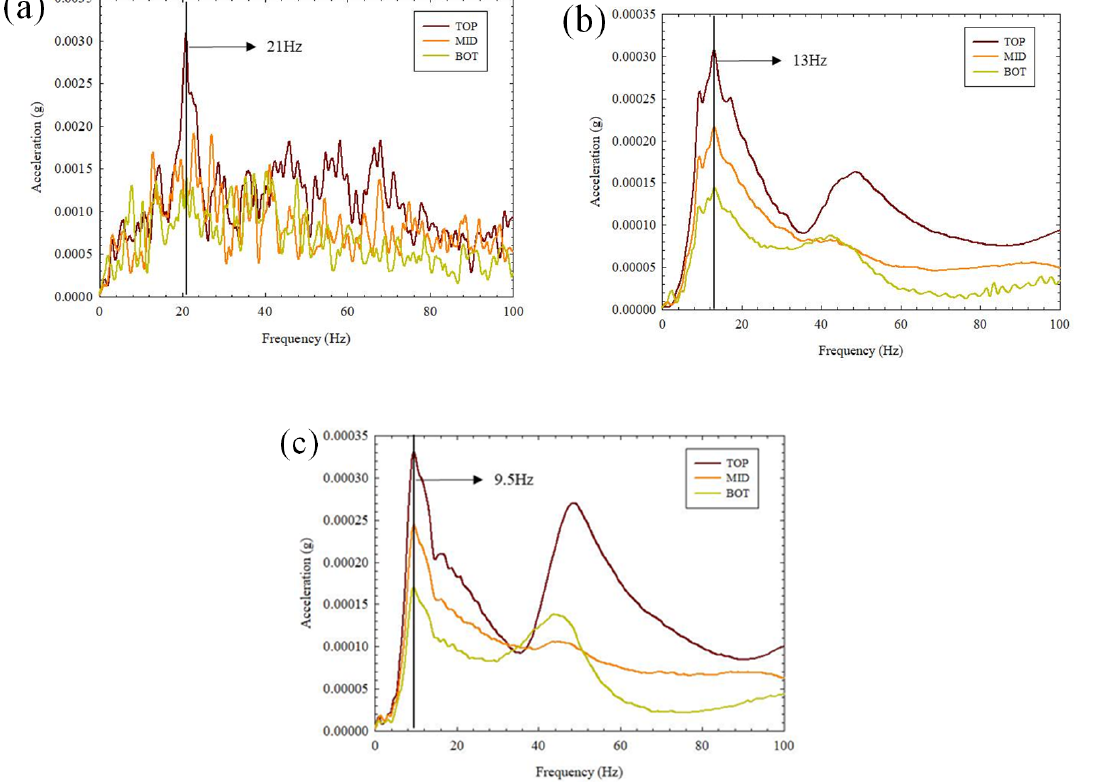
Figure 12. First mode natural frequency for each field condition. ( a ) With a girder; ( b ) Without a and ( c ) 1 m deep scour on the ground adjacent to the girder; and ( c ) 1 m deep scour on the ground adjacent to the pier.